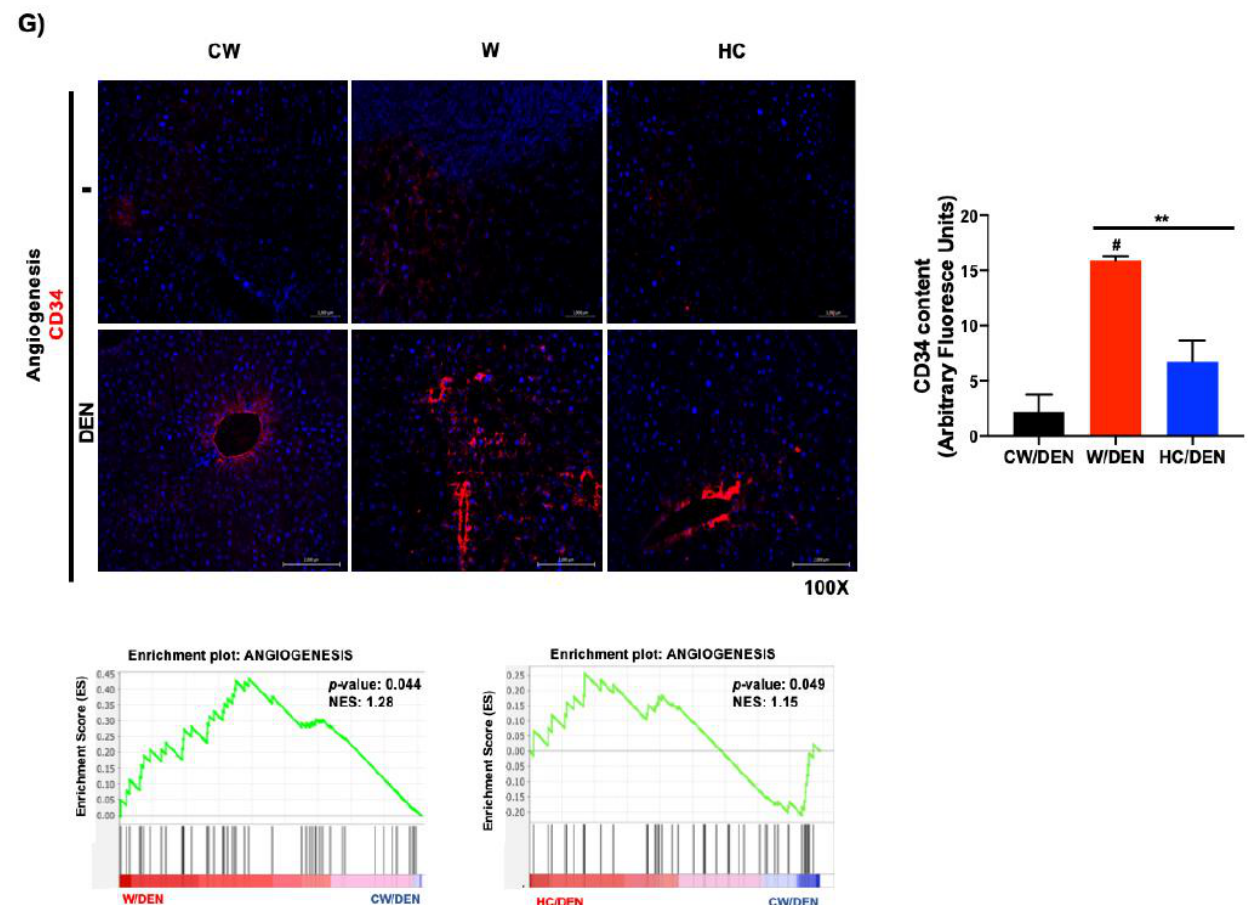
Figure 3. Tumors from lipid-enriched diets exhibit a profound change in gene expression favoring survival and proliferation signaling pathways and decreasing key tumor suppressor routes. Tumor tissues from mice fed with chow diet and injected with a single dose of N -nitrosodiethylamine (DEN, 10 µ g/kg, i.p.) (CW/DEN), mice fed with Western diet and injected with a single dose of DEN (W/DEN), mice fed with HC diet and injected with a single dose of DEN (HC/DEN) were subjected to RNA-sequencing as stated in Material and Methods. ( A ) Heatmaps showing the good separation of (A) W/DEN tumors vs. CW/DEN and ( B ) HC/DEN tumors vs. CW/DEN red and green colors indicate high and low gene expression, respectively ( n = 4). ( C ) Process networks analysis in tumors from CW/DEN (black), high cholesterol HC/DEN, (blue) and W/DEN (red) ( n = 4). The top rank-ordered processes and networks are based on statistical significance ( p < 0.01). ( D ) Expression targets of Stat3 and p53 in tumor signature. ( E ) Gene set enrichment analysis (GSEA) of liver cancer survival (down and upregulated) data sets comparing tumors from W/DEN and HC/DEN to CW/DEN. ( F ) Growth factors serum concentration of all mice groups. Proteins were determined by based multiplex immunoassay ( n = 4). Each bar represents the average ± SEM ** p < 0.01 vs. CW group; # p < 0.05 vs. W diet alone group. ( G ) Angiogenesis was judged by immunofluorescence of CD34, representative images of four animals. Original magnification, 100X. Quantification of CD34 fluorescence and GSEA of angiogenesis, data set comparing W/DEN and HC/DEN to CW/DEN ( n = 4).